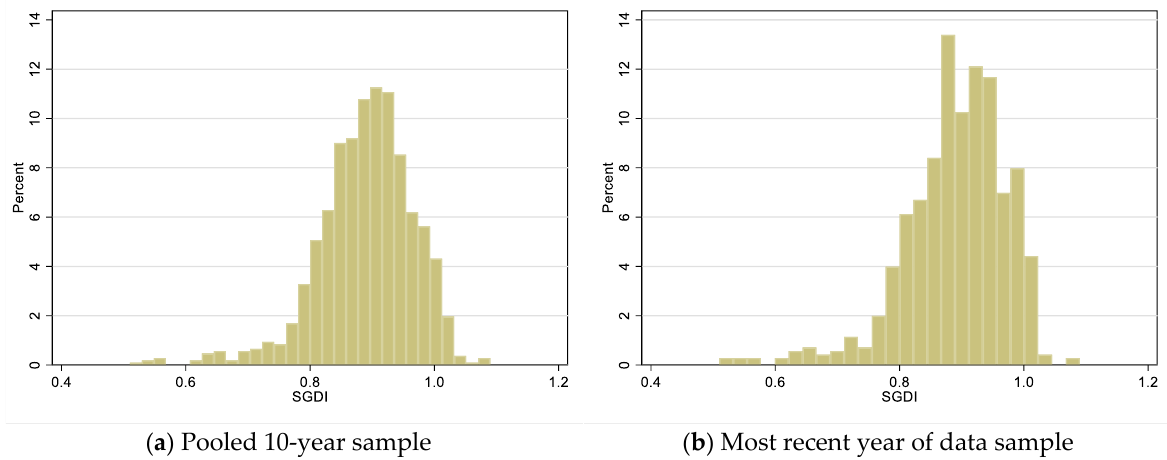
Figure 1. Distribution of Subnational Gender Development Index score.